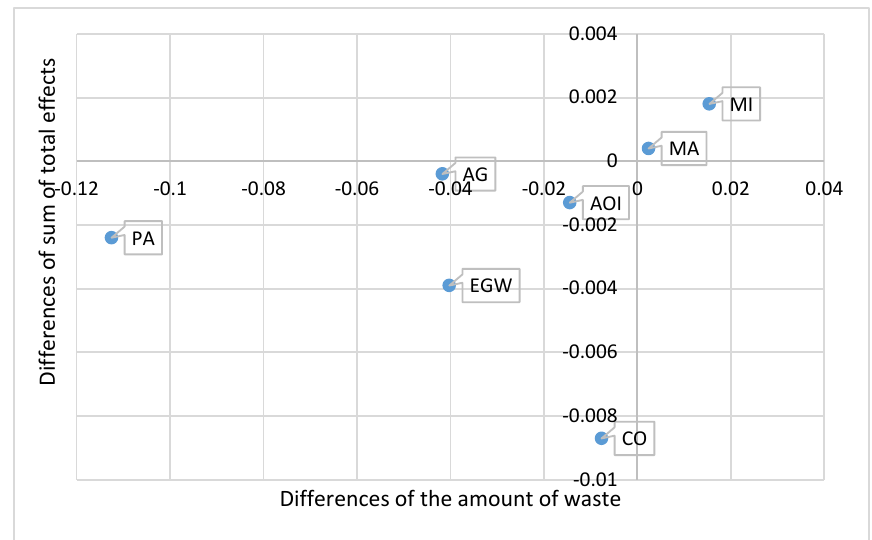
Figure 6. Relationships between differences of sum of total effects and the amount of waste generation in various sectors of the Australian economy, YEAR. Agriculture, forestry, and fishing = AG; Mining = MI; Manufacturing = MA; Electricity, gas, and water = EGW; Waste management services = WMS; Construction = CO; Public administration = PA; All other industry = AOI. Table 12. Direct, total, and the change of direct and total effects of sectors on waste treatment method (Landfill) in the Australian economy.